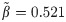
A new Ebola outbreak is possible if control is relaxed.Model fit for the number of new weekly reported cases, corresponding to the cumulative cases in Fig 4. The blue dots show new weekly cases reported by [7, 23, 24]. The red curve shows the fit obtained with parameter values in Table 1 up to week 40 (ending 3 Oct 2014). The dark green curve shows the model fit from the introduction of control measures at week 40 to week 59 (ending 13 Feb 2015), with parameter values in Table 2. The light green curve shows model prediction until week 200 (ending 27 October 2017). The gray curve shows the model prediction assuming that, at week 120 (ending 15 April 2016), intervention strategies are relaxed to the following values: β~=0.521, θ~=0.235, ϕ~=1.708, 1/b~=5.2 and 1/η~=4.6.